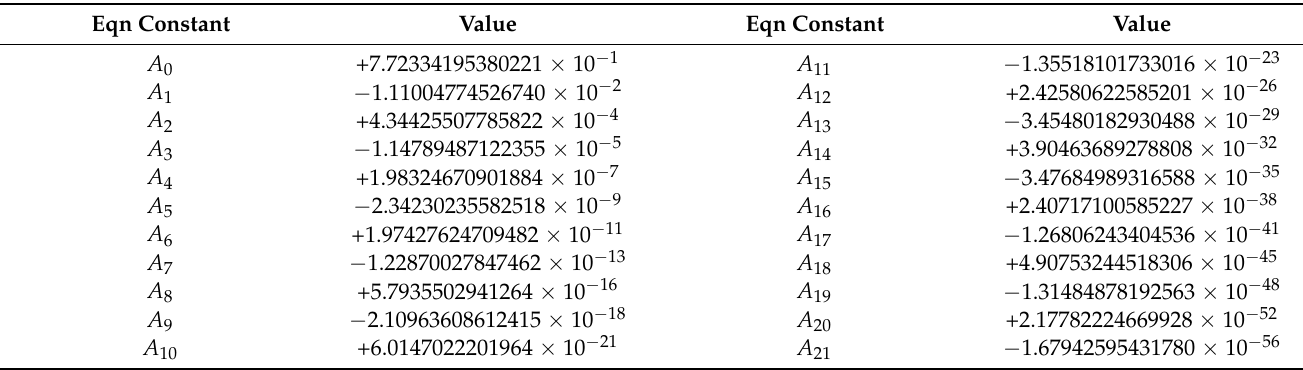
Table 2. Constant values for the porosity-depth relationship shown in Equation